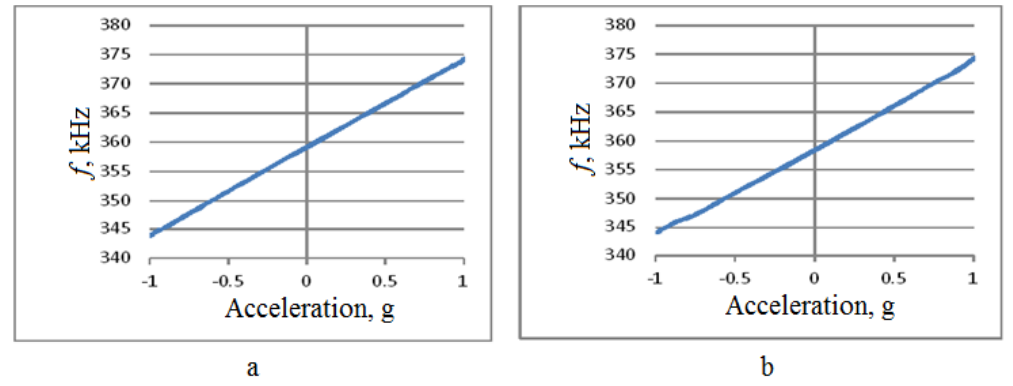
Figure 13. The output characteristic for rotations around the z -axis. ( а ) — Rotation from − 180° to 0°; ( b ) — rotation from 0° to +180°.